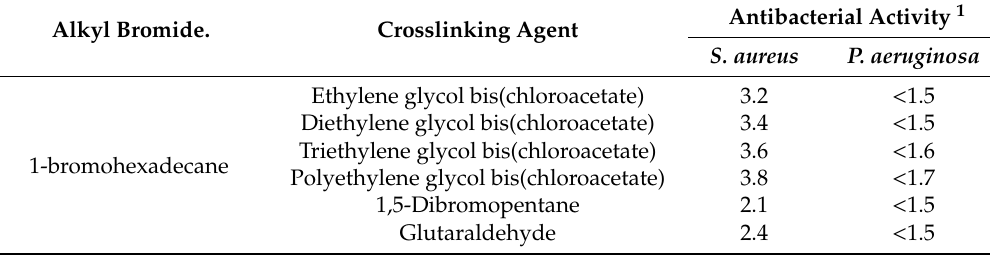
Table 1. The influence of the crosslinker type on the antimicrobial activity of quaternary ammonium polyethylenimine (QA-PEI) nanoparticles against S. aureus and P. aeruginosa . Data from [84]. Alkyl